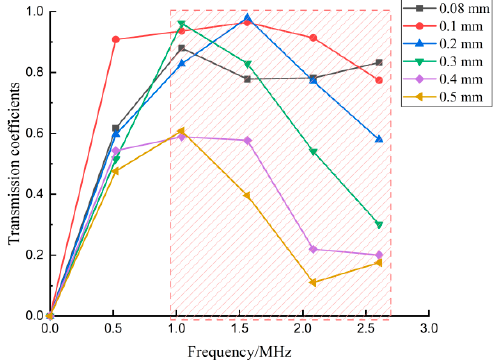
Figure 12. Experimental transmission coefficients